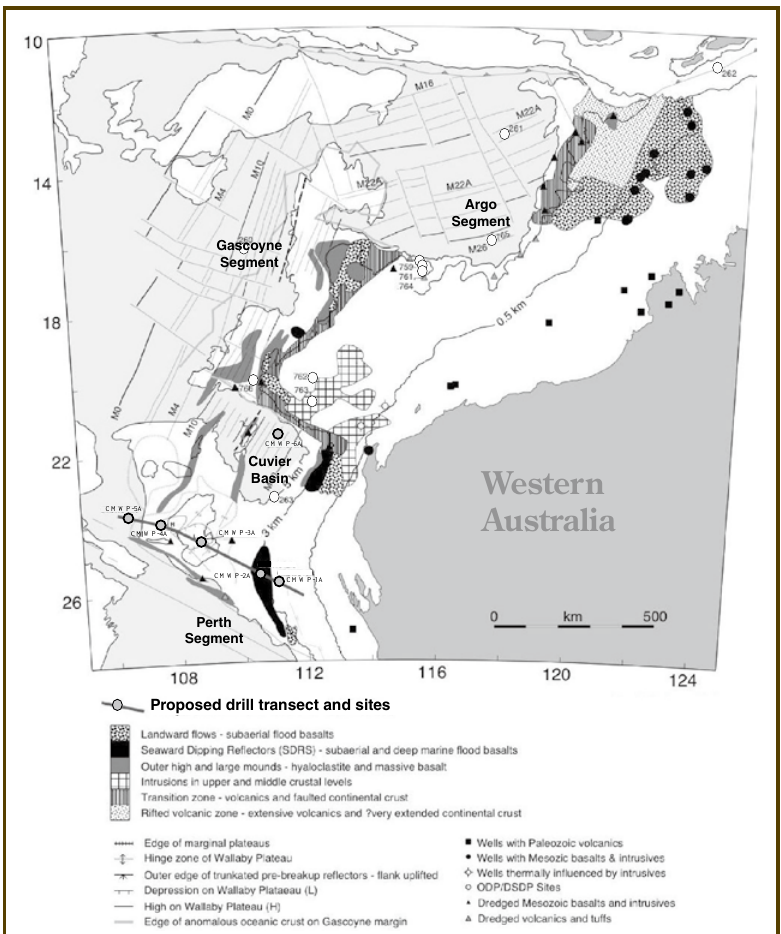
Figure 10. Regional setting of northwest Australian margin with proposed IODP sites.